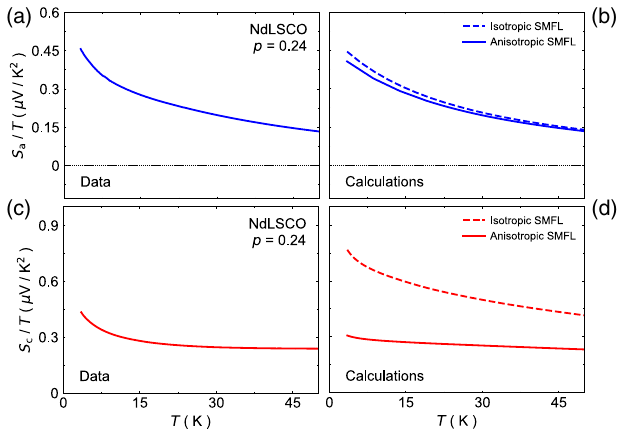
FIG. 10. Left: Seebeck coefficient of Nd-LSCO p ¼ 0 . 24 for both the a axis (blue) (a) and c axis (red) (c). Right: correspond- ing calculated Seebeck coefficients (b,d) for a momentum- independent but energy-dependent skewed scattering rate 1 = τ þ 1 = τ ð ϵ ; T Þ , with B ¼ 0 in Eq. (A5) for the elastic 0 SMFL scattering rate (isotropic, dashed line) and a momentum- and energy-dependent skewed scattering rate of the form 1 = τ 0 ð 1 = τ ð ϵ ; T Þ (anisotropic, full line), the same as in Fig. SMFL